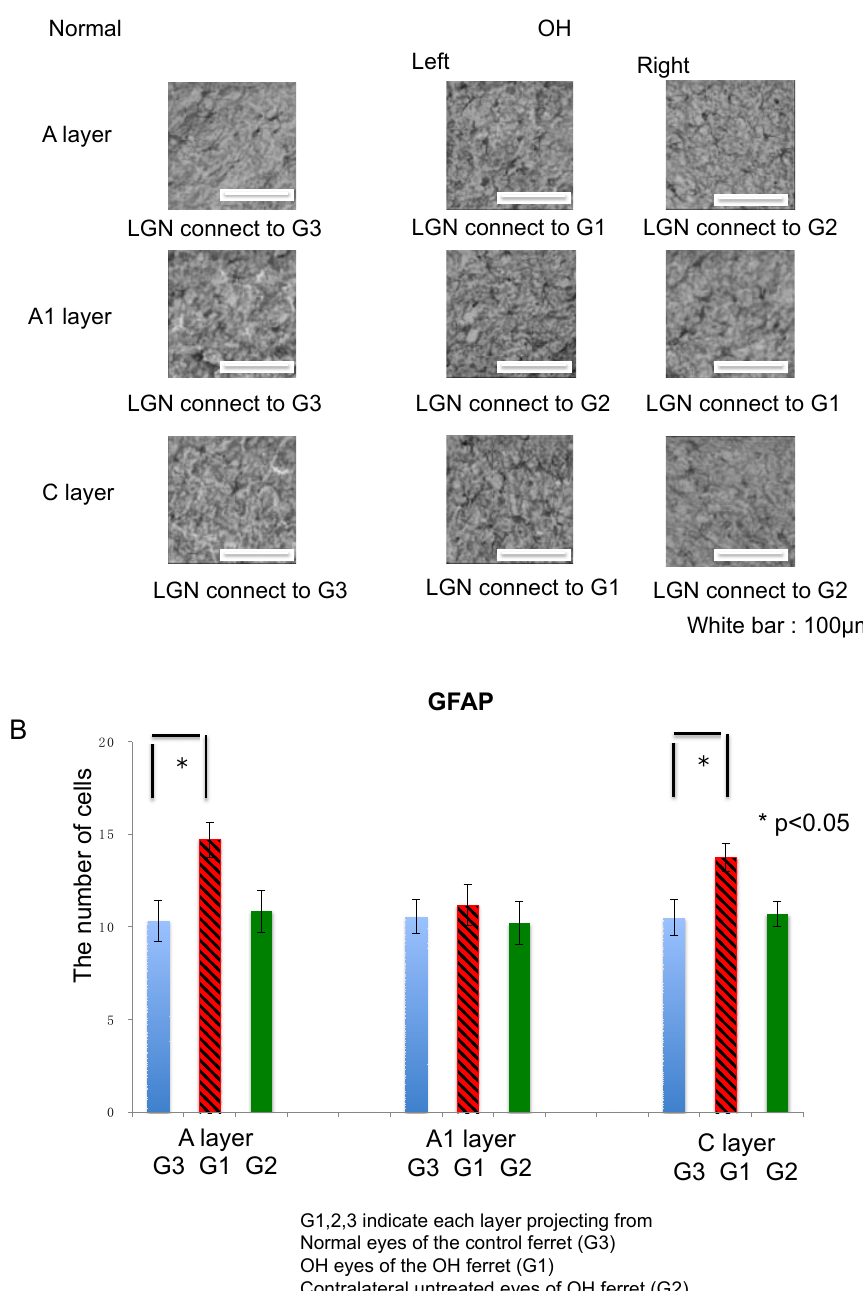
Figure 5. Immunohistological images of neuroglial cells in LGN of the OH (G1) and the untreated contralateral eyes (G2) of the OH ferret, and the normal eyes (G3) of the control ferret. ( A ): GFAP staining indicating microglia. (200 µ m × 200 µ m square; white bar = 100 µ m). Comparison of neuroglial cells in LGN layers projecting from the OH (G1) and the untreated contralateral eyes (G2) of the OH ferret, and the normal eyes (G3) of the control ferret. ( B ): The number of GFAP immunoreactive glial cells. Significant increase of the number of GFAP-1-immunoreactive cells were observed in the A and C layers of G1, compared with those of G3 ( n = 10, paired t -test, p < 0.05). There were no significant differences in GFAP immunoreactivity in the A, A1, and C layers of the LGN on either side in normal ferrets. In OH ferrets, GFAP immunoreactivity was increased and evenly distributed across all layers and reactive astrocytes were observed.